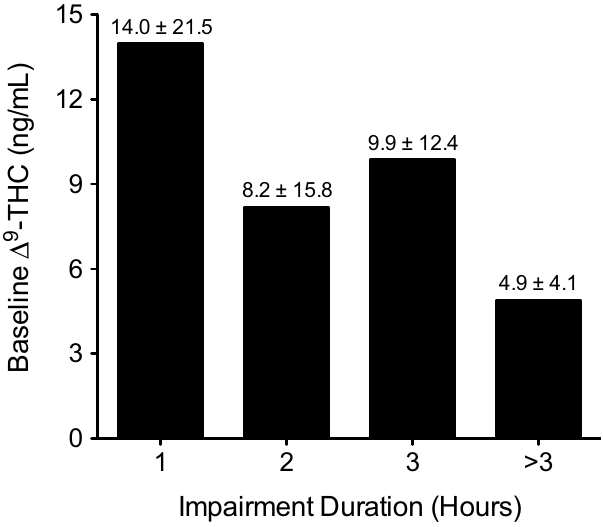
Figure 3. Post-smoking duration of impairment compared to baseline ∆ 9 -THC blood concentration in 64 subjects. As determined by self-assessment, subjects were stratified by duration of impairment [1 h ( N = 19), 2 h ( N = 24), 3 h ( N = 17), > 3 h ( N = 4)] after smoking a 500-mg cannabis cigarette. Mean ∆ 9 -THC concentration (± SD) is shown above each bar.